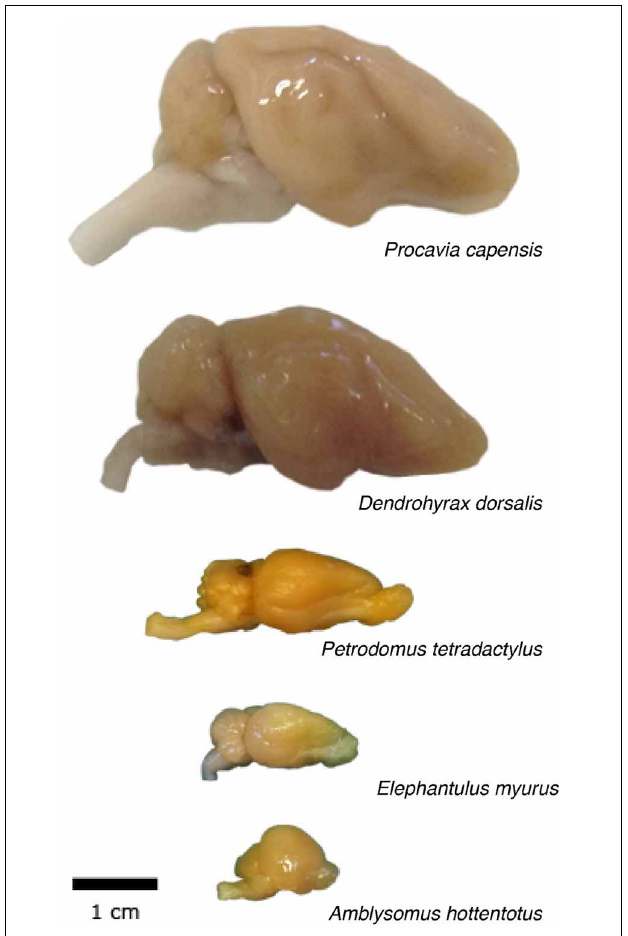
FIGURE 1 | Overview of the morphology of the afrotherian brains used in the study.